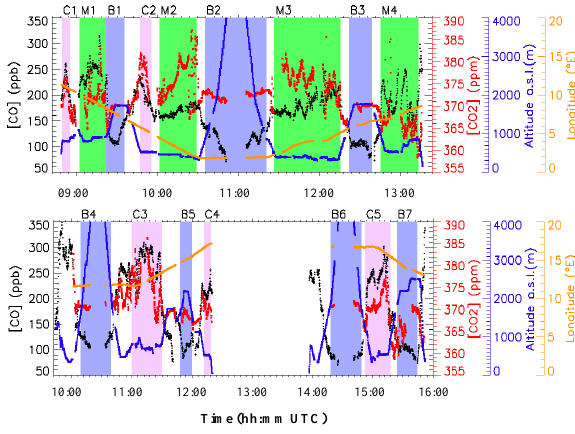
Fig. 7. CO, CO 2 and altitude time series during the CAATER 2 flights (top: 2 October 2002; bottom: 3 October 2002). Striking events have been selected with colorbars (pink is for C: high CO and CO 2 correlation level events, green is for M: mixed determination factor events, blue is for B: tropospheric background